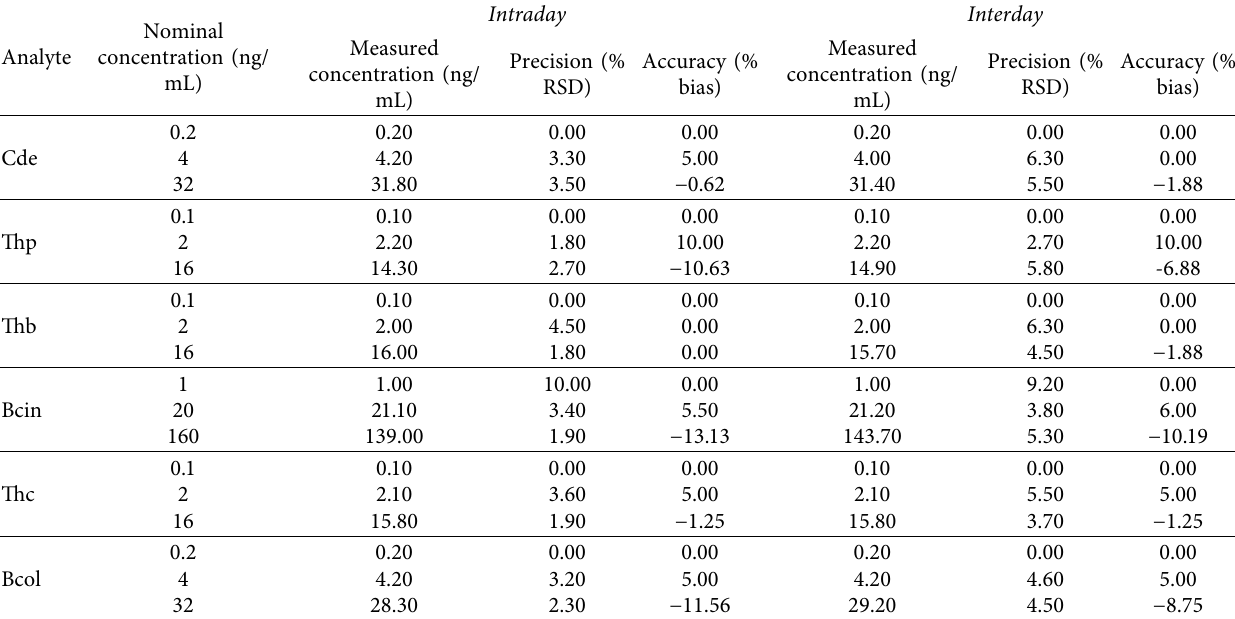
Table 5: Accuracy and precision of the six analytes in dog plasma (mean, n � 3 days, 6 replicates per day). Analyte